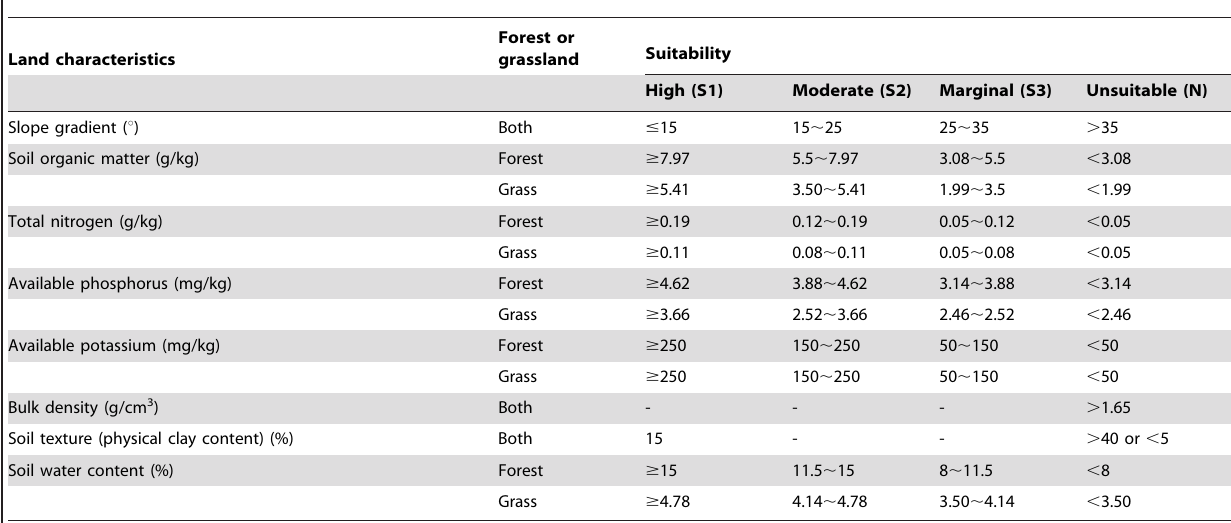
Table 8. Land characteristics, thresholds and degree of suitability for forest and grasslands.